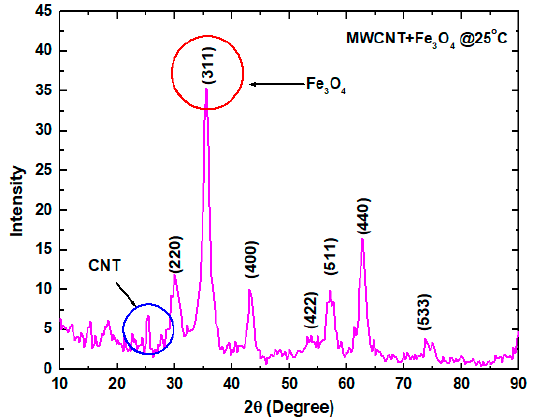
Figure 2. XRD patterns of MWCNT + Fe 3 O 4 hybrid nanoparticles.